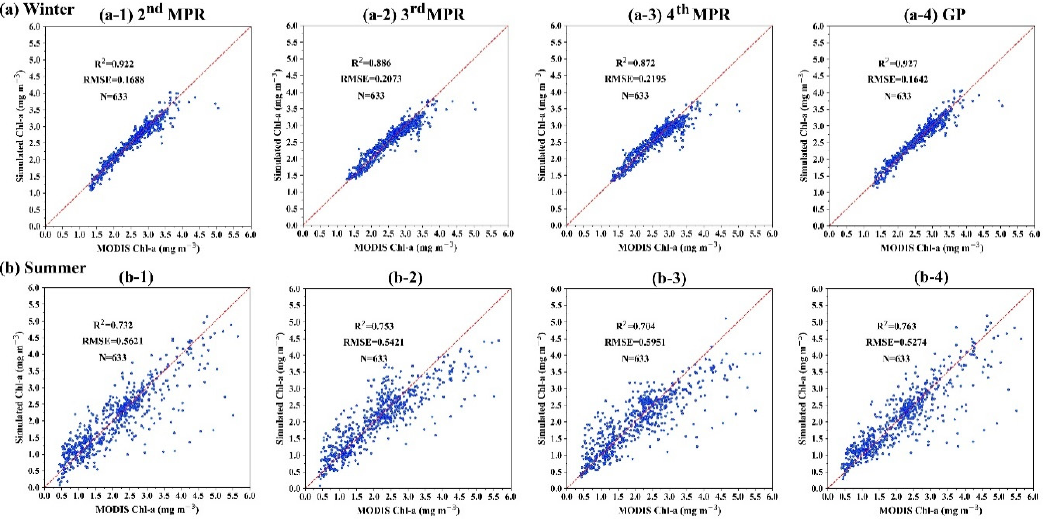
Figure 5. 1:1 scatter plots of the original MODIS Chl-a at 4 km pixel size vs. downscaled MODIS Chl-a at 10 m pixel size; ( a ) the winter day (2016.2.2): ( a-1 ) 2 nd -degree MPR, ( a-2 ) 3 rd -degree MPR, ( a-3 ) 4 th -degree MPR, ( a-4 ) GP, and ( b ) the summer day (2016.8.4): ( b-1 ) 2 nd -degree MPR, ( b-2 ) 3 rd -degree MPR, ( b-3 ) 4 th -degree MPR, and ( b-4 )